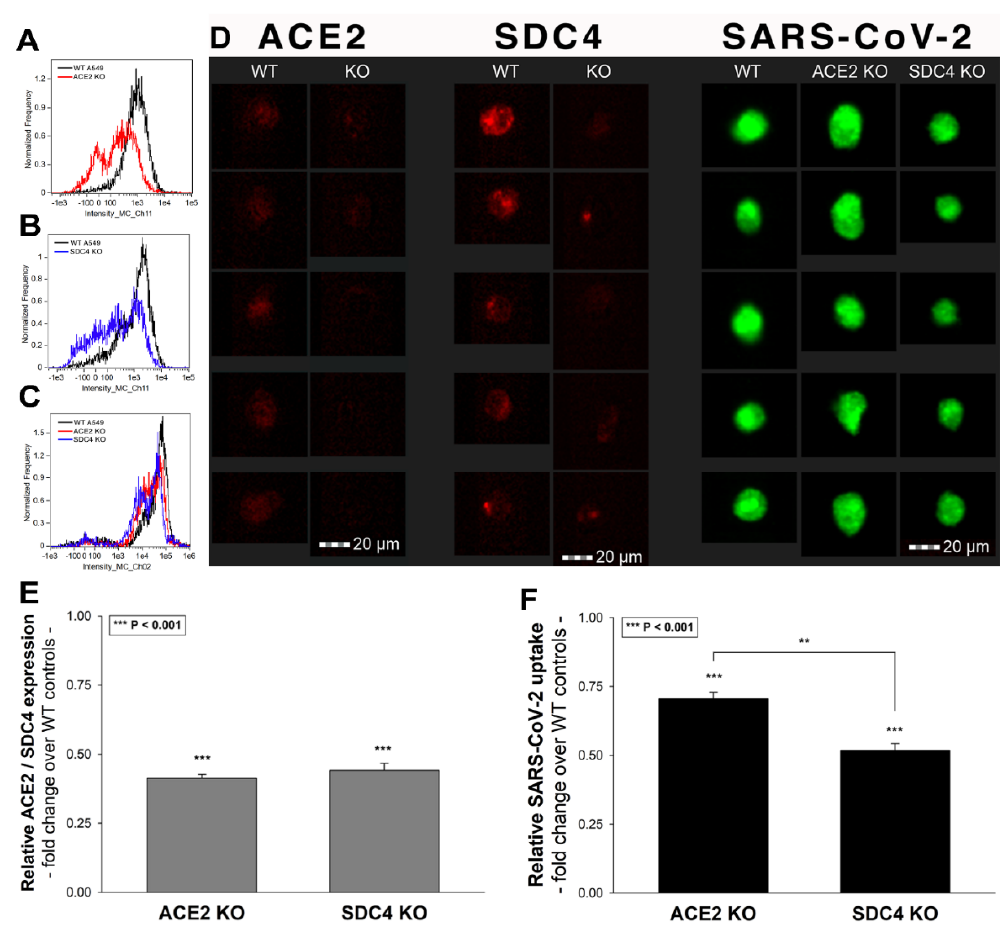
Figure 10. Effect of ACE2 or SDC4 knockdown on SARS-CoV-2 cellular entry. SDC4 and ACE2 knockdown in A549 cells was performed using a lentiviral vector system specific to human ACE2 and SDC4 shRNA. Stable KO cells were then selected, and along with WT A549 cells, were incubated with heat-inactivated SARS-CoV-2 (at 1 MOI) for 18 h at 37 °C. ( A , B ) Representative flow cytometry histograms showing ACE2 and SDC4 expression levels of WT A549, ACE2 ( A ) and SDC4 KO ( B ) cells. ( C ) Representative flow cytometry histograms showing the intracellular fluorescence of SARS-CoV-2-treated WT A549, ACE2 KO and SDC4 KO cells. ( D ) Imaging flow cytometry visualization of ACE2 and SDC4 expression, along with SARS-CoV-2 internalization of WT A549, ACE2 KO and SDC4 KO cells. Representative images of four independent experiments are shown. Scale bar = 20 μm. ( E ) Relative ACE2 and SDC4 expression levels of ACE2 KO and SDC4 KO cells. Detected ACE2 and SDC4 expression levels were normalized to those of WT A549 cells as standards. The bars represent the mean ± SEM of three independent experiments. Statistical significance vs. standards was assessed with analysis of variance (ANOVA). *** p < 0.001. ( F ) Detected intracellular fluorescence intensities of SARS-CoV-2-treated ACE2 and SDC4 KO cells were normalized to SARS-CoV-2-treated WT A549 cells as standards. The bars represent the mean ± SEM of three independent experiments. Statistical significance vs. standards (i.e., SARS-CoV-2-treated WT A549 cells) and between ACE2 and SDC4 KO cells were assessed with ANOVA. ** p < 0.01; *** p < 0.001.